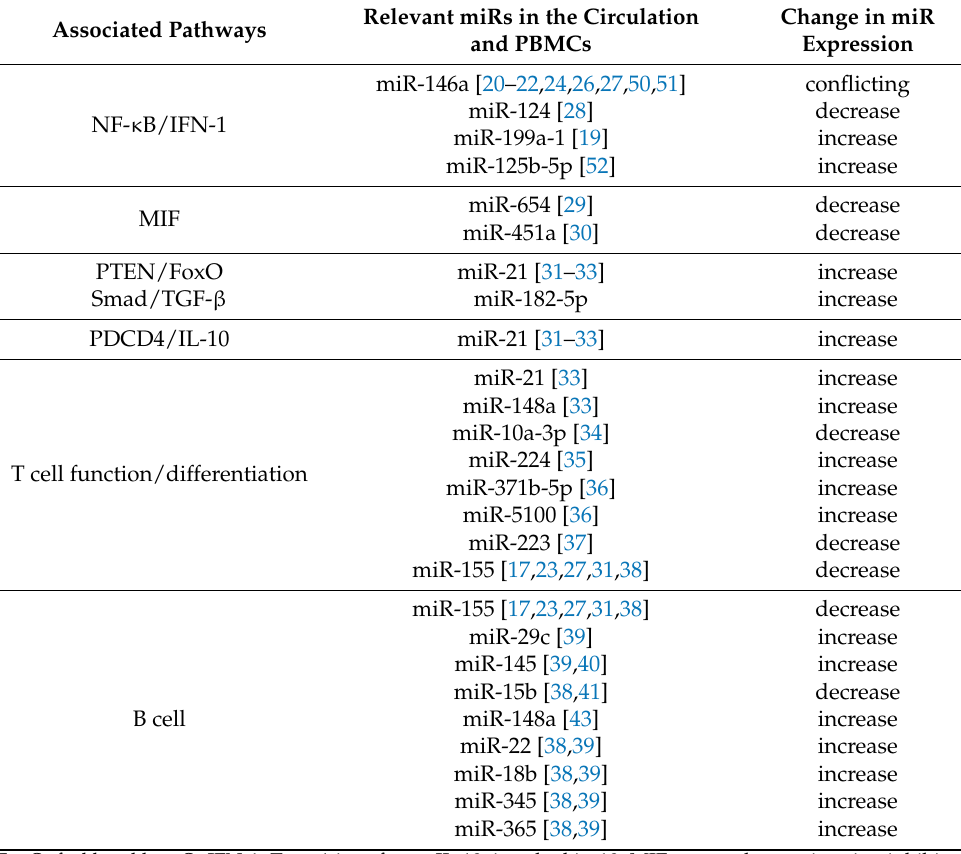
Table 1. Signal transduction pathways involved in the pathogenesis of LN and the expression of relevant miRs in the circulation and